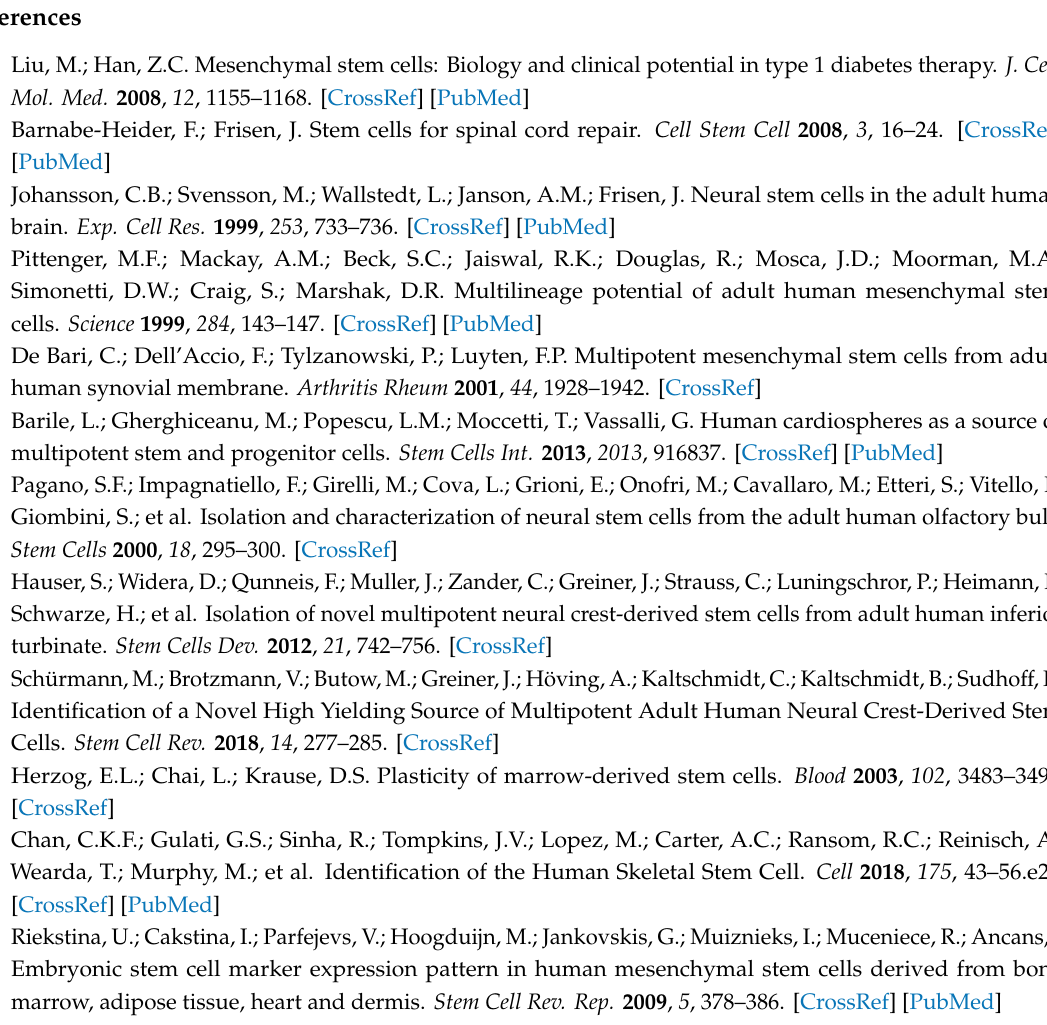
Figure S1: Molecular characterization of ITSCs. ( A ) Cultured ITSCs express the neural crest stem cell markers S100 and Nestin. ( B ) Neurogenic di ff erentiation potential of ITSCs, Table S1: Corresponding gene identities to the heatmap in Figure